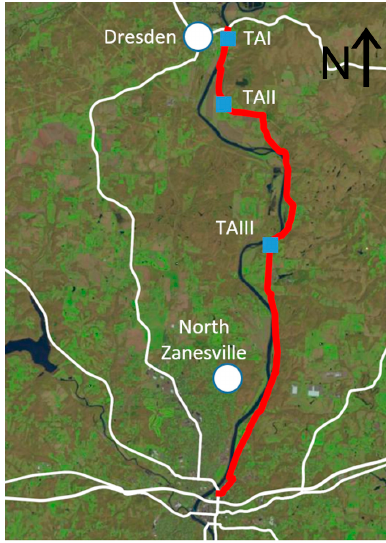
Figure 5. Distribution of Testing Areas (TA) -I, -II, and -III along SR 666 shown by blue squares.